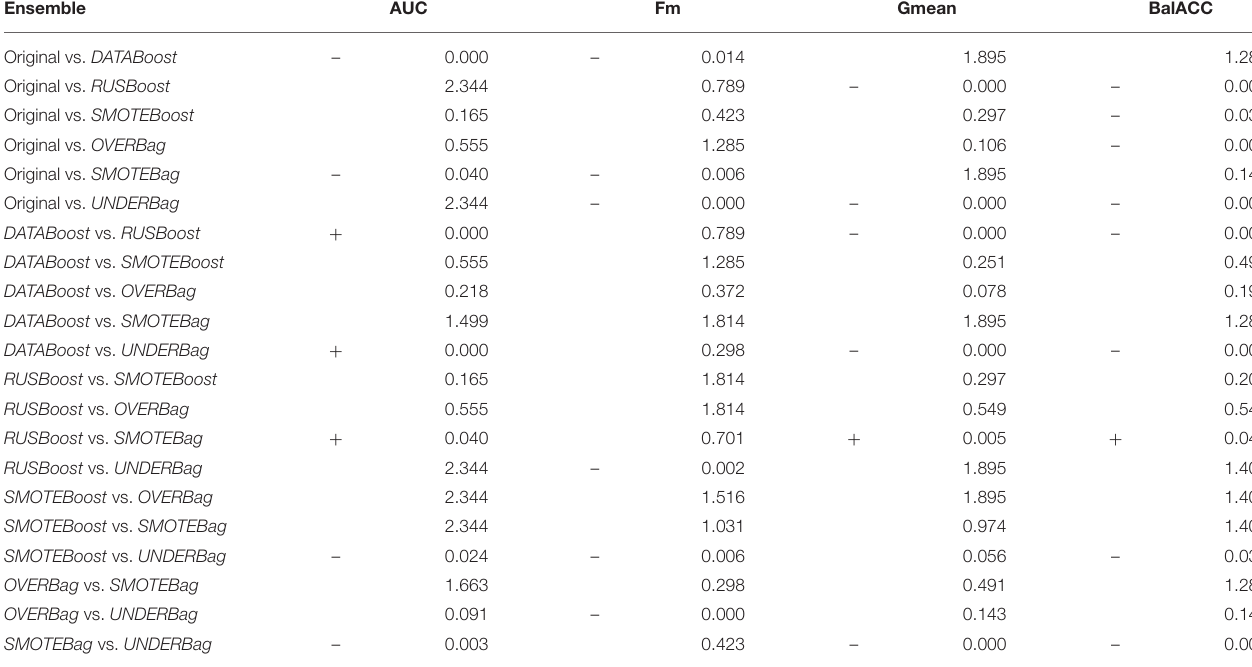
TABLE 5 | Shaffer’s test for the ensemble approaches for the imbalance domain. Ensemble AUC Fm Original vs. DATABoost